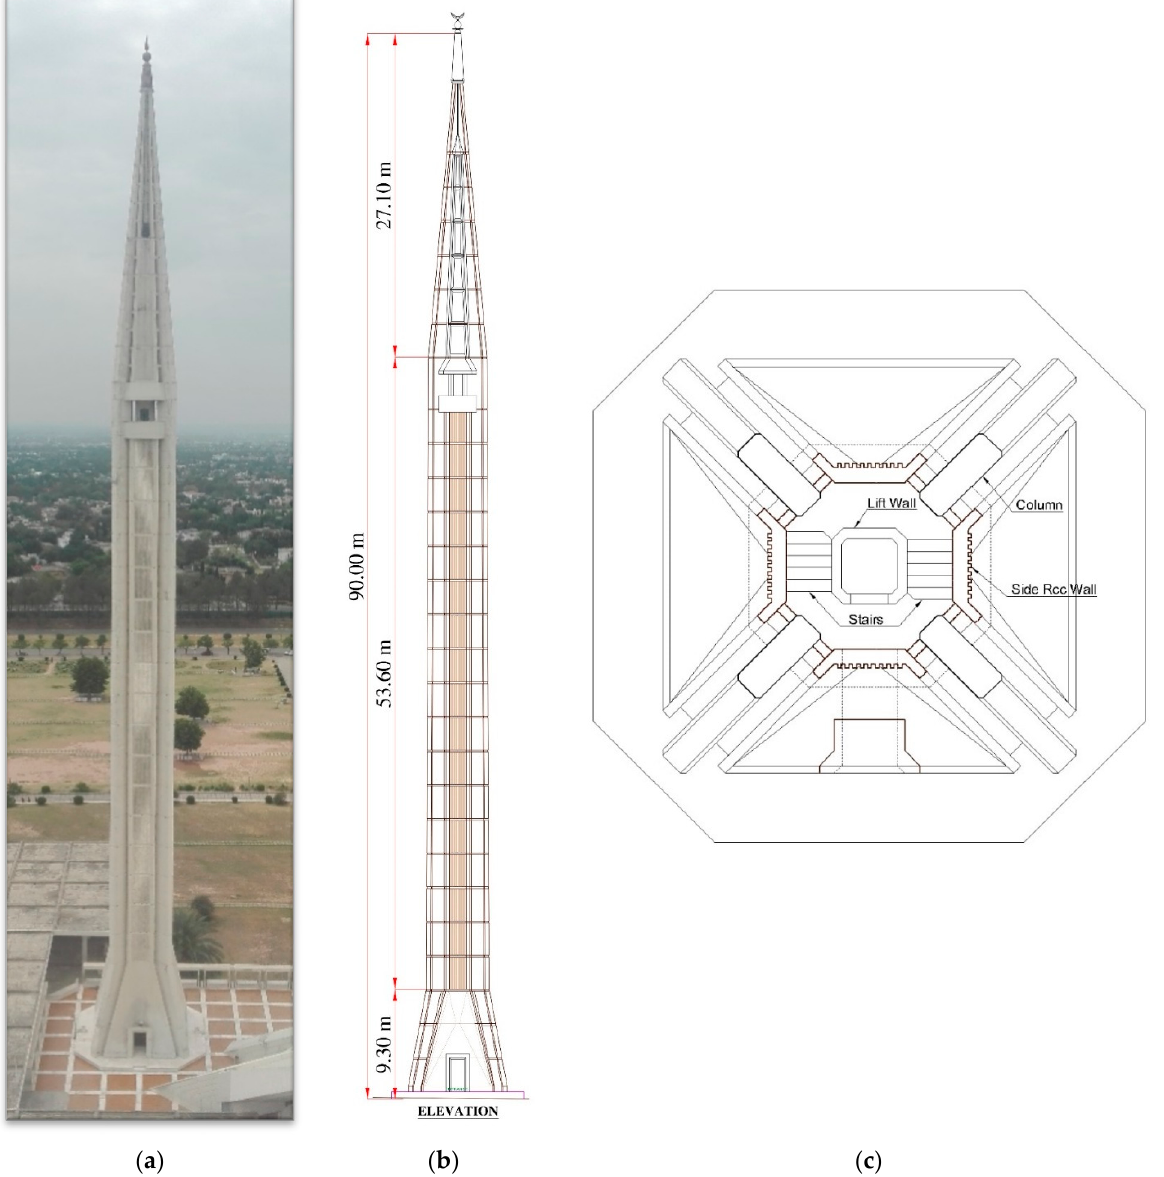
Figure 2. ( a ) A picture of a minaret. ( b ) Elevation view of the minaret. ( c ) Cross-sectional view of the minaret.